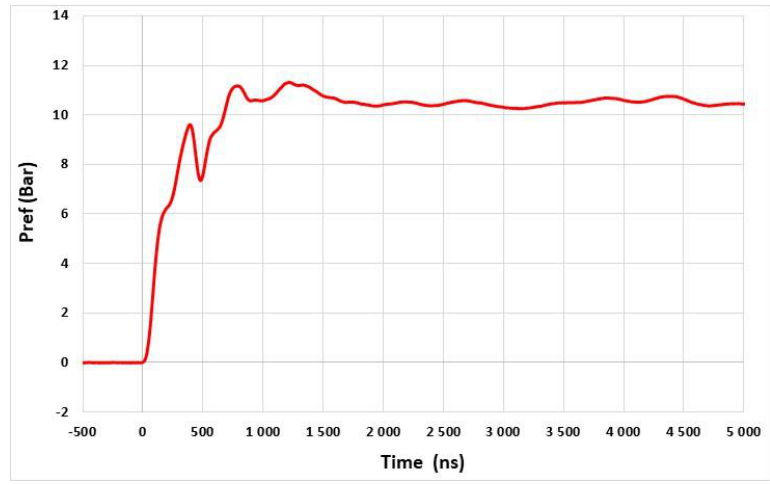
Figure 25. Response of the reference pressure sensor PCB134A.